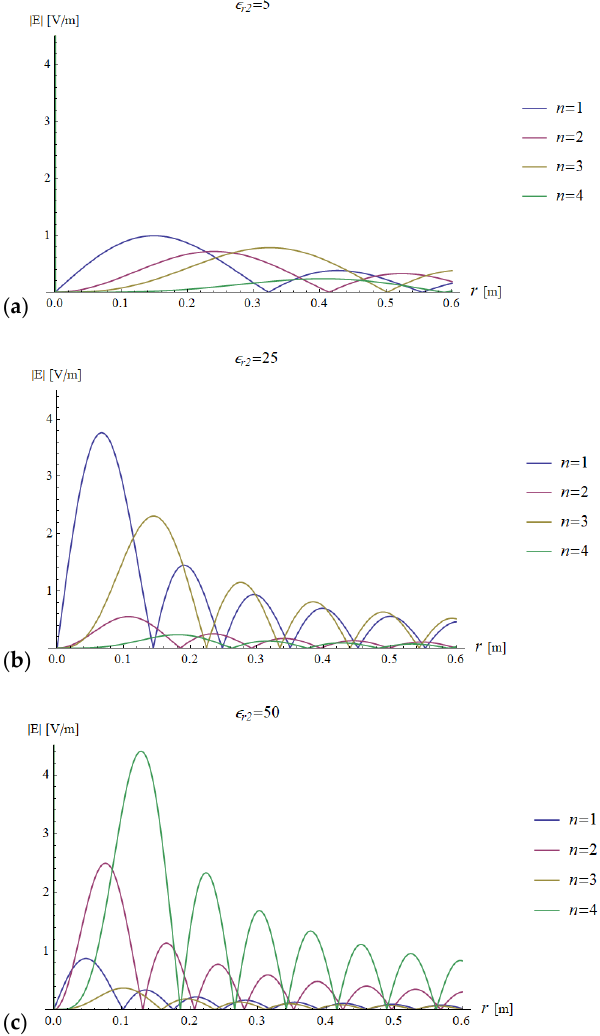
Figure 11. Electric field distribution as a function of the radial coordinate in a lossless ( σ = 0 S/m) sphere of radius a = 0.6 m for the first four modes. Results are plotted for different values of relative permittivity ( ε r 2 = 5, 25 and 50 in ( a – c ), respectively).